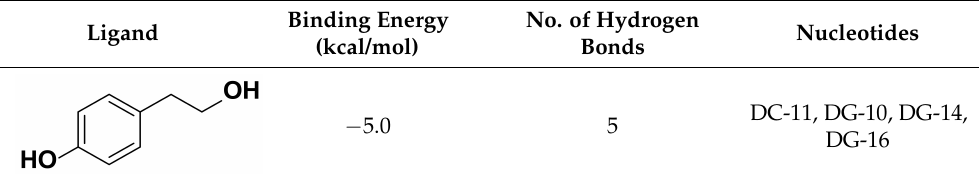
Table 8. Binding scores of the docked tyrosol on the active site of